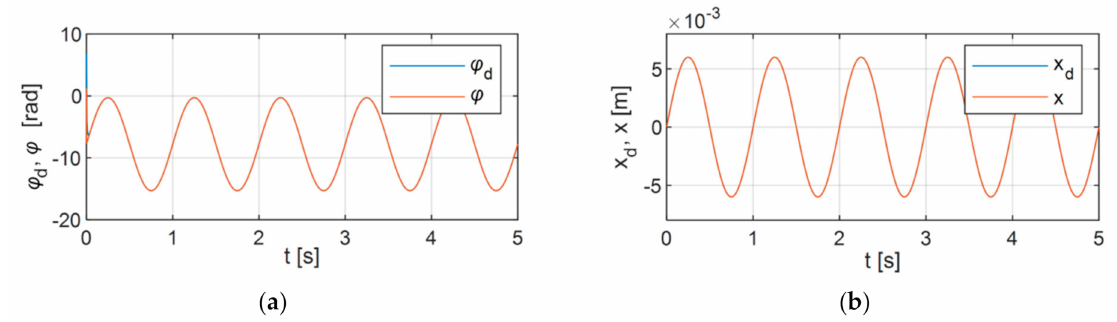
Figure 12. Trajectory: ( a ) adjusted ϕ d and realized ϕ positions of the active part; ( b ) adjusted x d and realized x positions of the passive part.